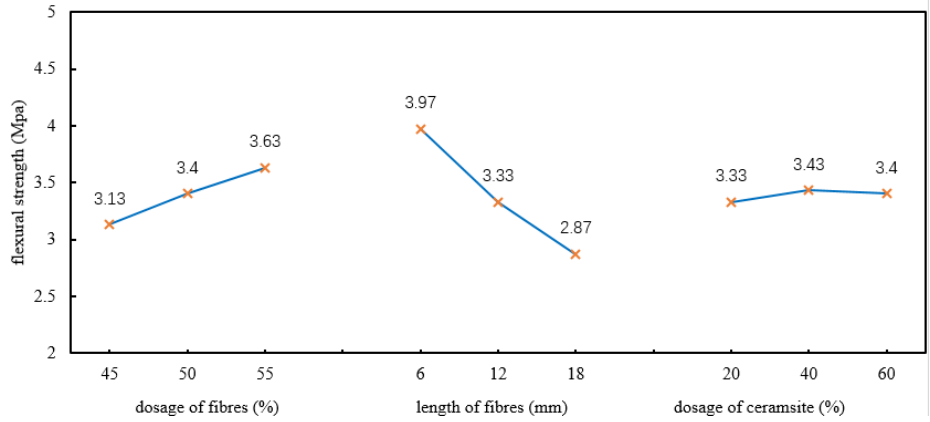
Figure 3. Trend in the flexural strength.